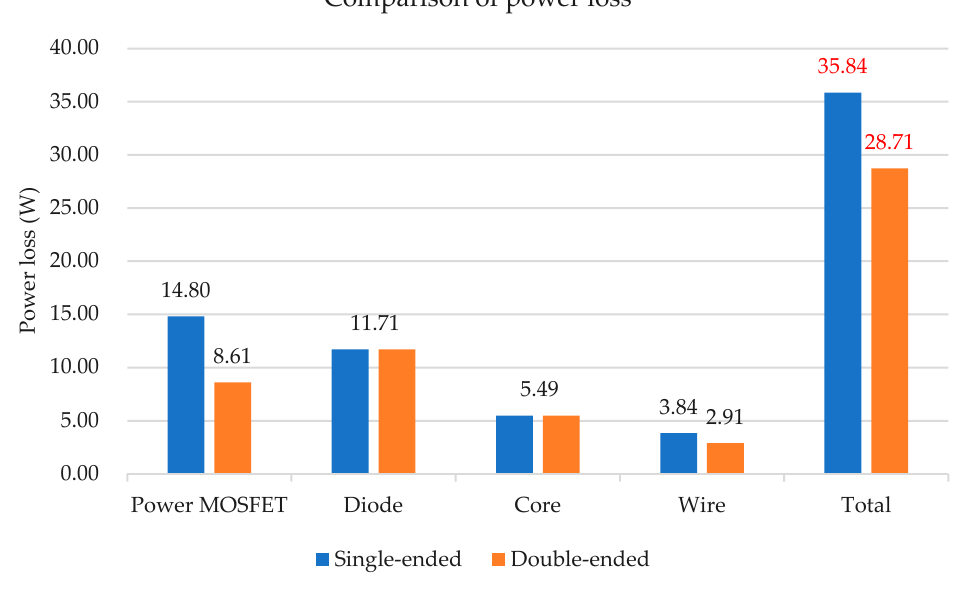
Figure 15. Comparison of power